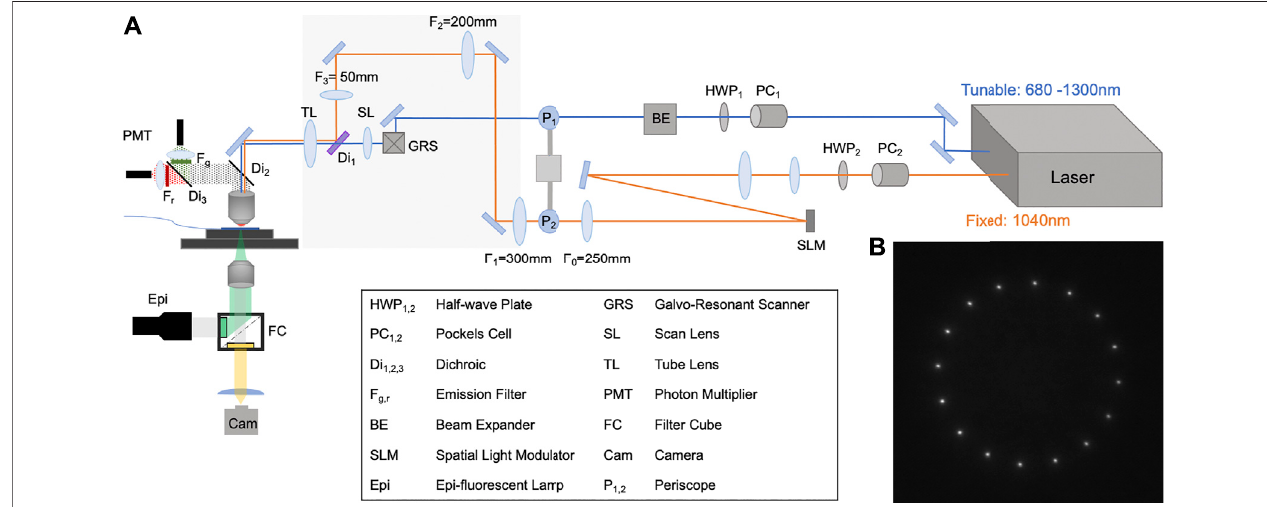
FIGURE 5 | Two-photon optical layout and result (A) Schematic of the optical layout for two-photon photo-stimulation and imaging. The two-photon photo- stimulation path uses the fi xed output of the laser (Coherent Chameleon Discovery), shown in orange, and is shaped by a BNS 1536 × 1536 SLM in a virtual-lens con fi guration with an F vl (cid:1) 600 mm. The two-photon imaging path that uses the tunable output of the laser is shown in blue and is scanned by a galvo-resonant pair (GRS).Thetwobeamsarecombinedbyanotchdichroic(Di 1 ,SemrockNFD01-1040)beforeenteringtheobjective.Thebottominvertedmicroscope,shownbelow thesampleplane,isaNikonTE200withadditionalmotorizedstageandfocusdrive,connectedtoaHamamatsuImagEMX2EMCCD,collectsthe fl uorescentlight.Note that there is no 0 th order block in this layout. (B) The two-photon image formed by the SLM captured by the inverted microscope. Only the intended target points are generated by the two-photon excitation.